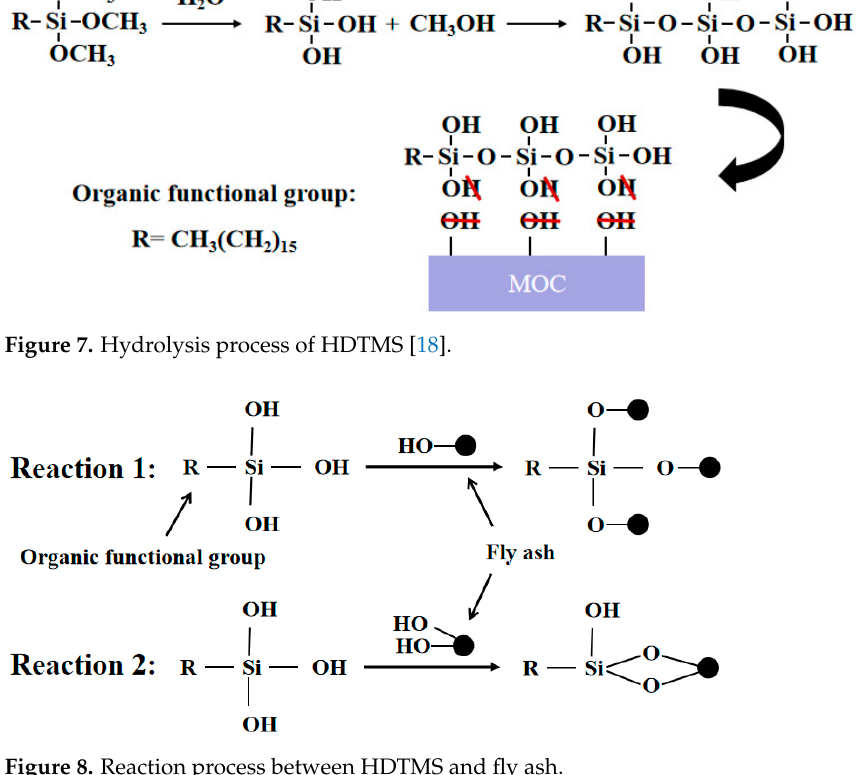
Figure 8. Reaction process between HDTMS and fly ash.